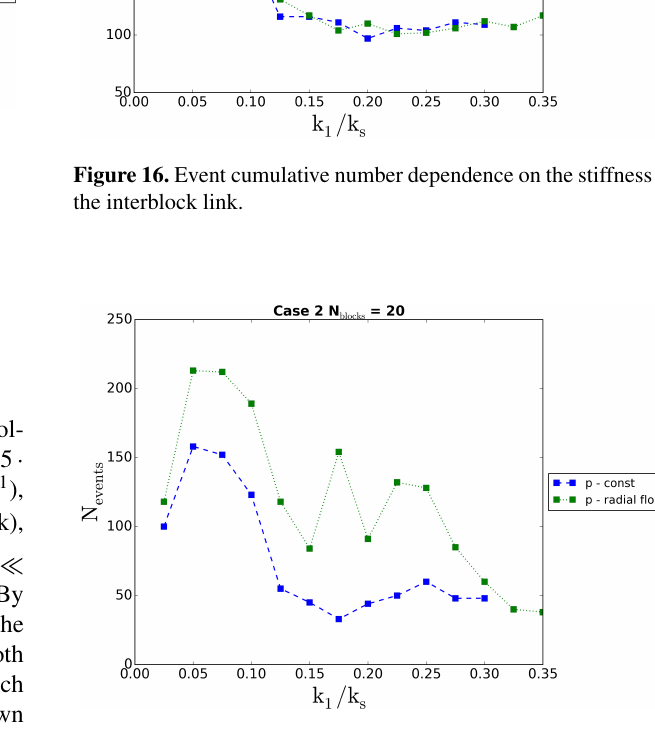
Figure 17. Event cumulative number dependence on the stiffness of the interblock